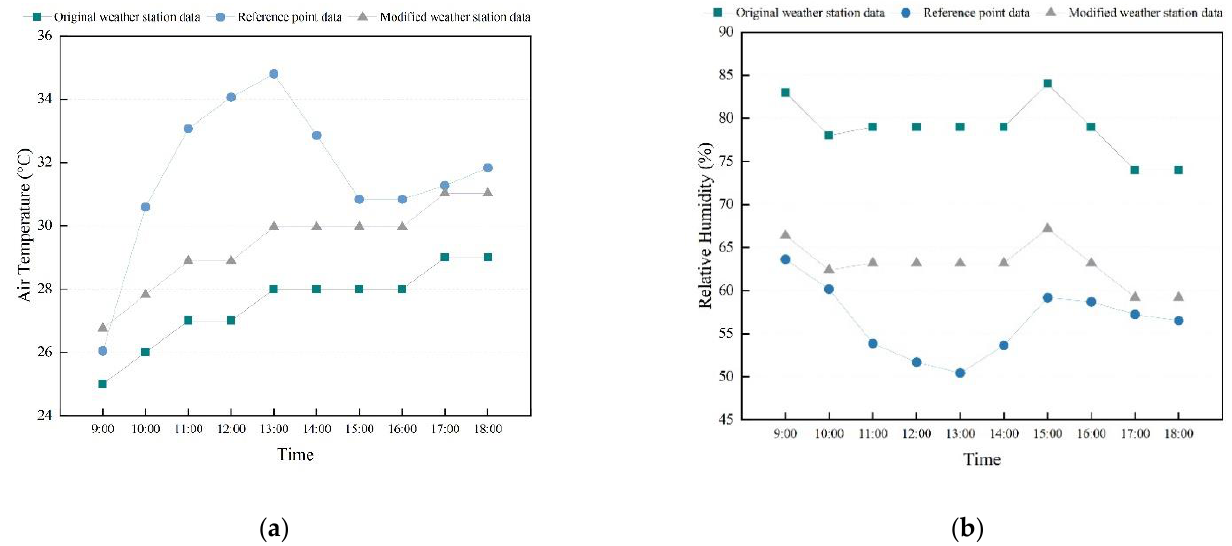
Figure 3. The comparison of the reference point data and weather station data: ( a ) AT; ( b ) Rh. Table 3. Microclimate simulation settings and meteorological parameters of the model input in ENVI-met.